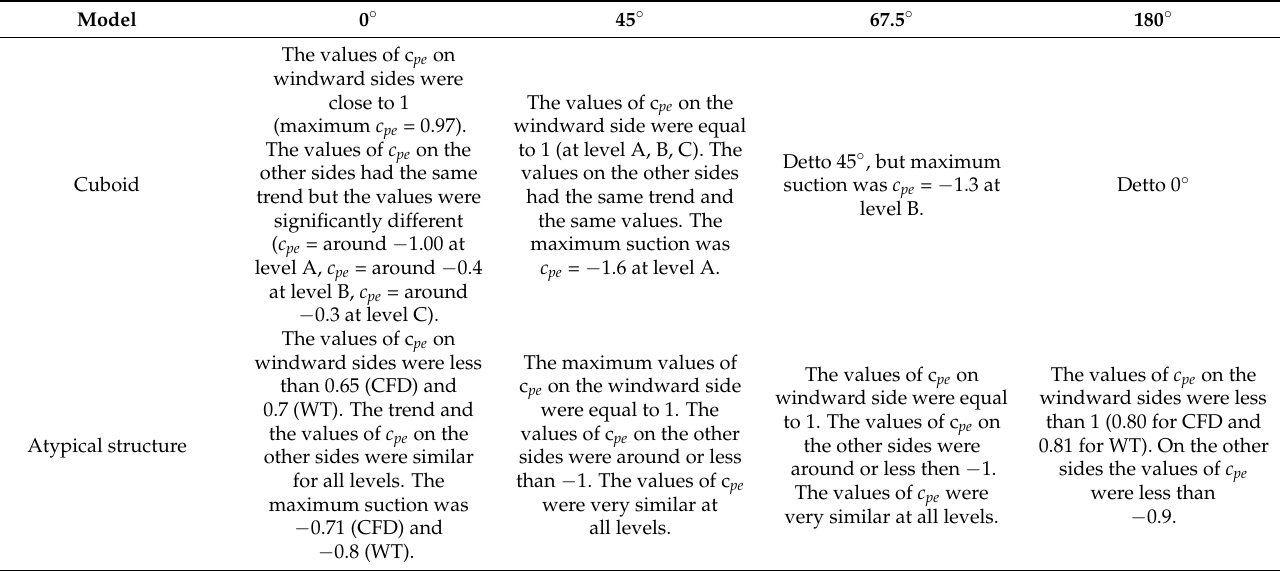
Table 2. The conclusions—the CFD vs. WT tests—the cuboid vs. atypical structure. Model 0 ◦ 45 ◦ 67.5 ◦ 180 ◦